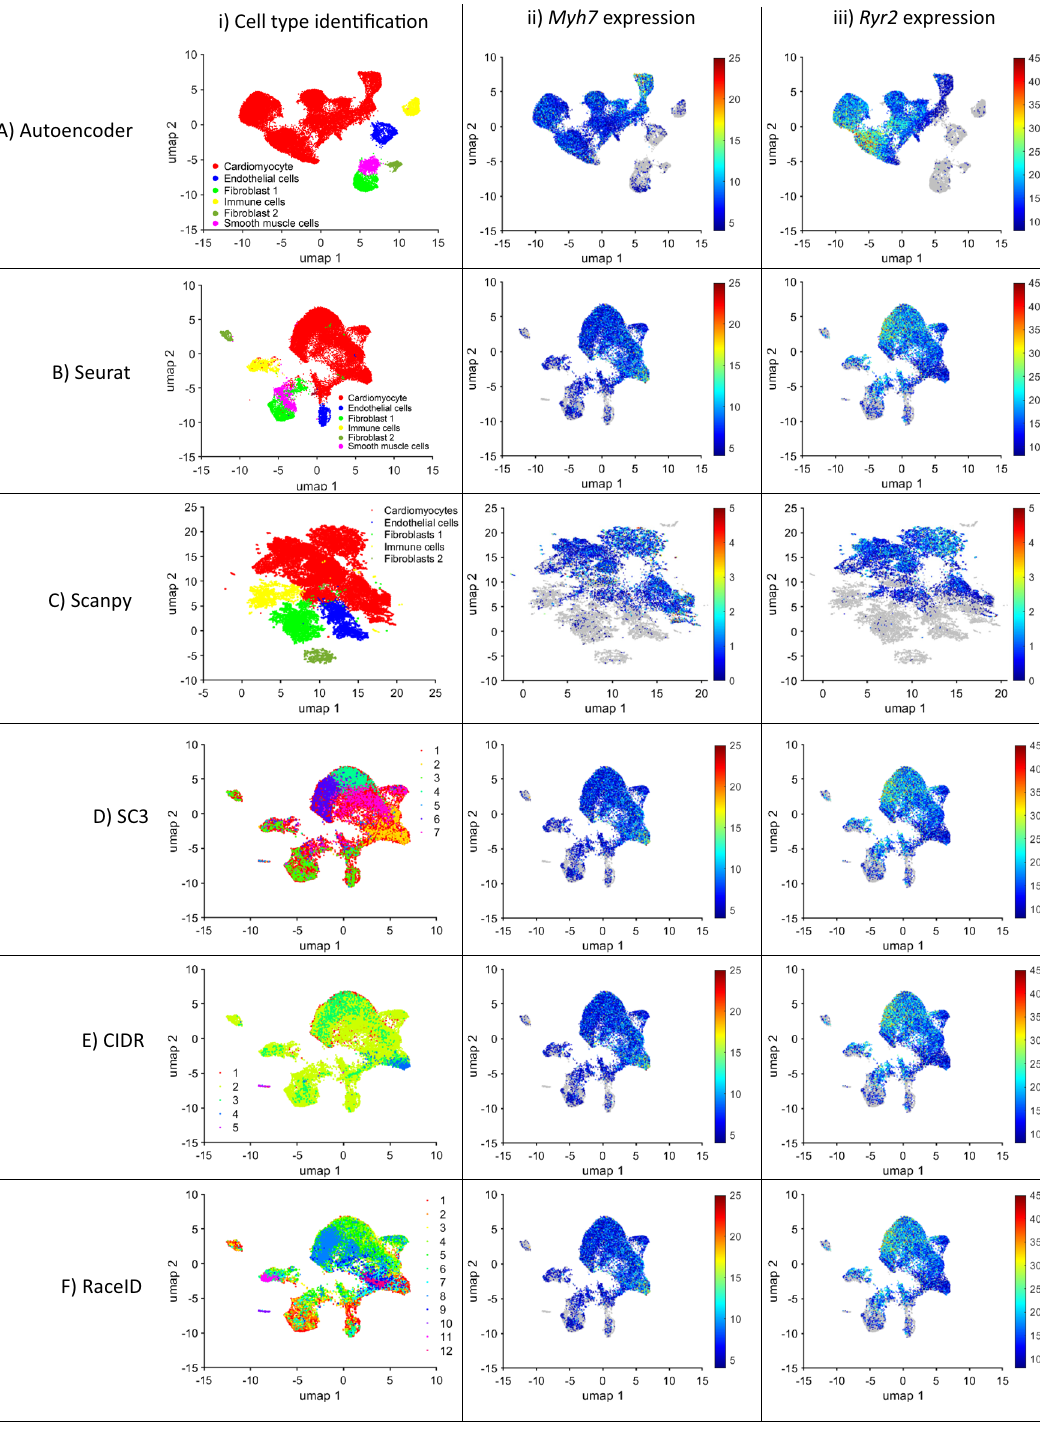
Figure 2. AI Autoencoder was more effective than non-AI tools for cluster analysis of scRNAseq data from mouse hearts . Cluster analysis of mouse heart scRNAseq data was conducted via ( A ) AI Autoencoder, ( B ) Seurat, ( C ) ScanPY, ( D ) SC3, ( E ) CIDR, ( F ) RaceID, ( G ) scDHA, ( H ) ssCCCEES or ( I ) DCA and (Column i) displayed via UMAP for identification of cell-type specific clusters. (Column ii) Myh7 and (Column iii) Ryr2 expression was quantified across the corresponding UMAP and presented as a heat